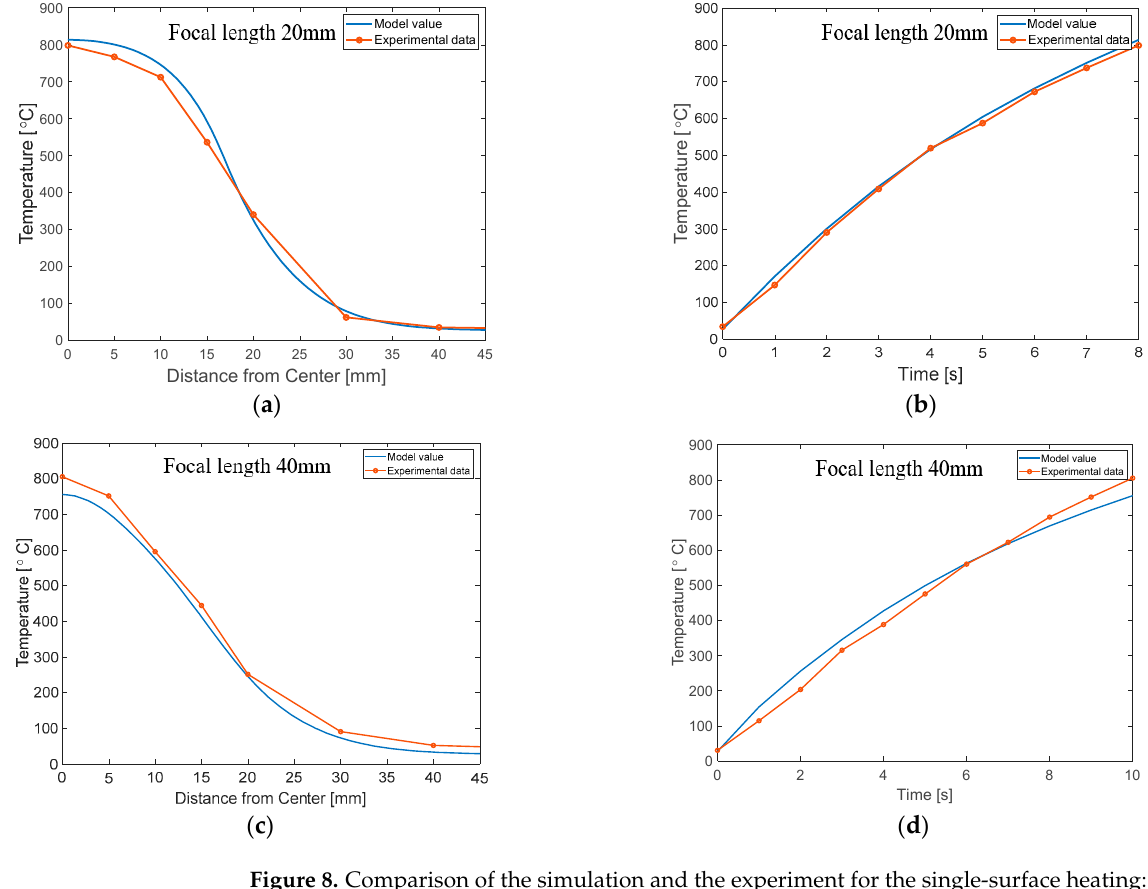
( d ) Figure 9. Comparison of the simulation and experiment for the double-surface heating: ( a ) Temper- ature profile of the target material for the 20 mm focal length; ( b ) Heating rate at the center for the 20 mm focal length; ( c ) Temperature profile of the target material for the 40 mm focal length; ( d ) Heating rate at the center for the 40 mm focal length.